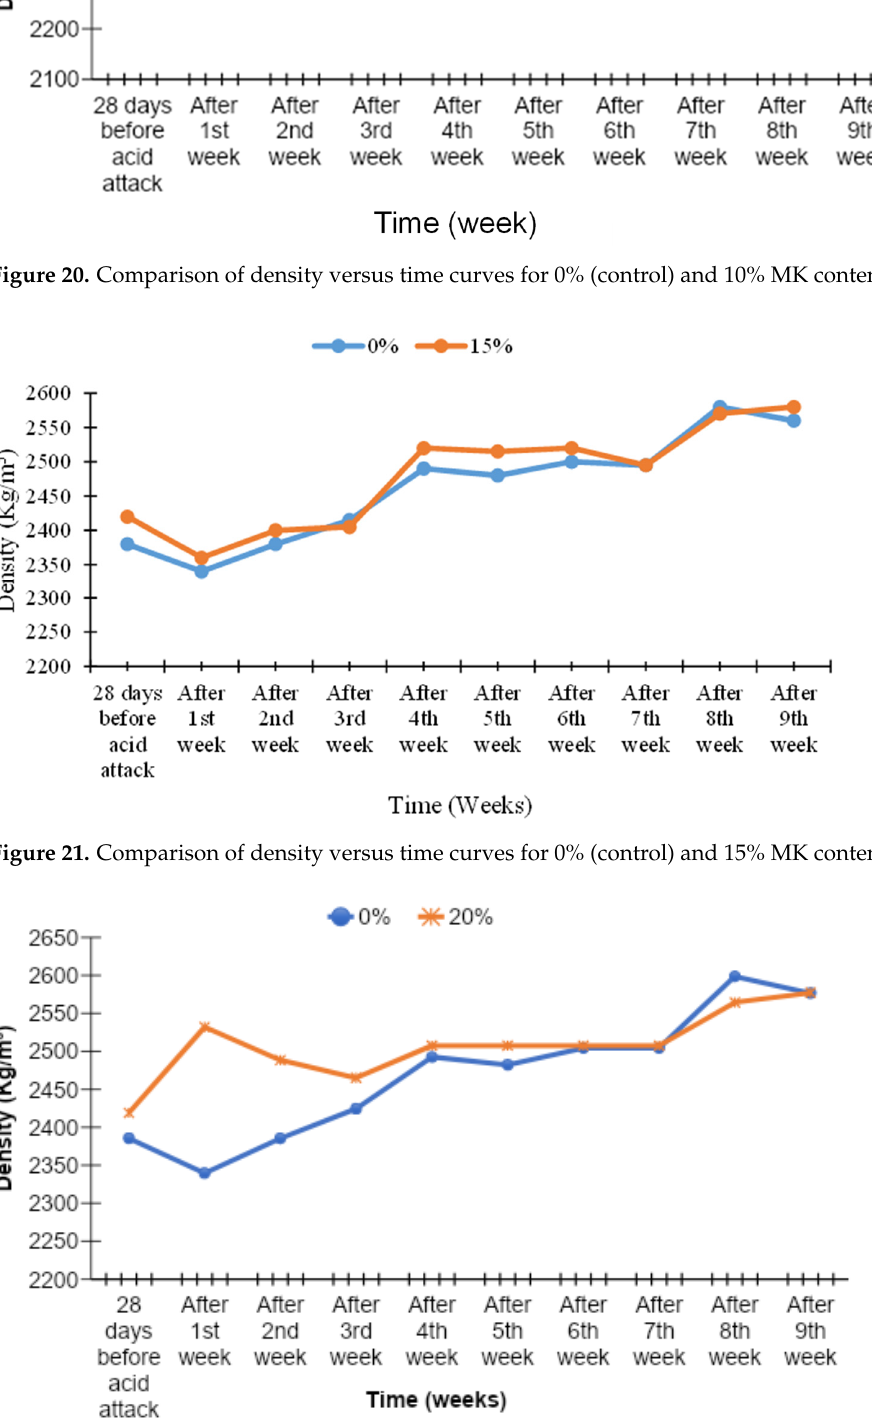
Figure 22. Comparison of density versus time curves for 0% (control) and 20% MK Figure 21. Comparison of density versus time curves for 0% (control) and 15% MK contents.